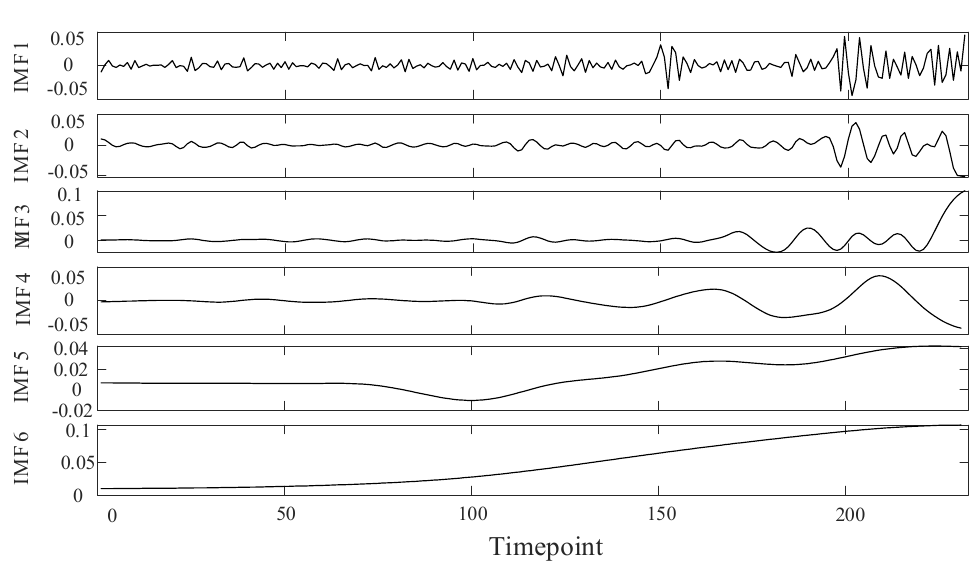
Figure 14. Modal components of the CDI.